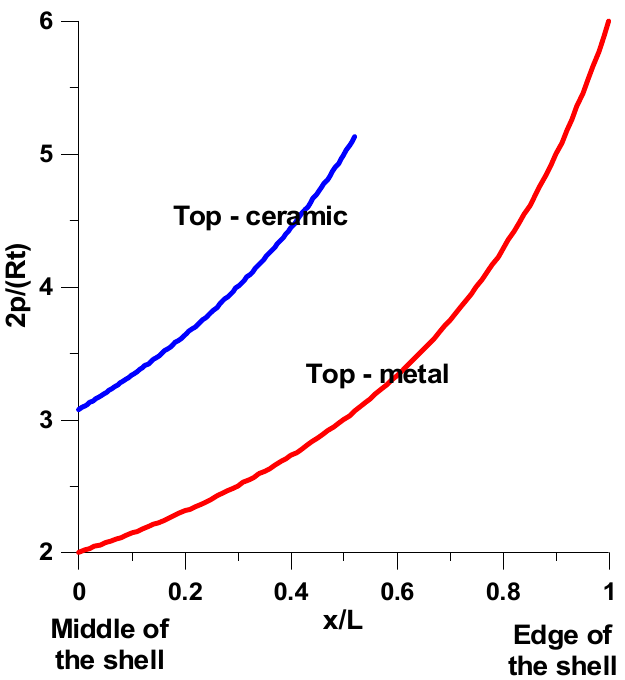
Figure 7. Contact reactions with vessels made of unsymmetric FGM layers.